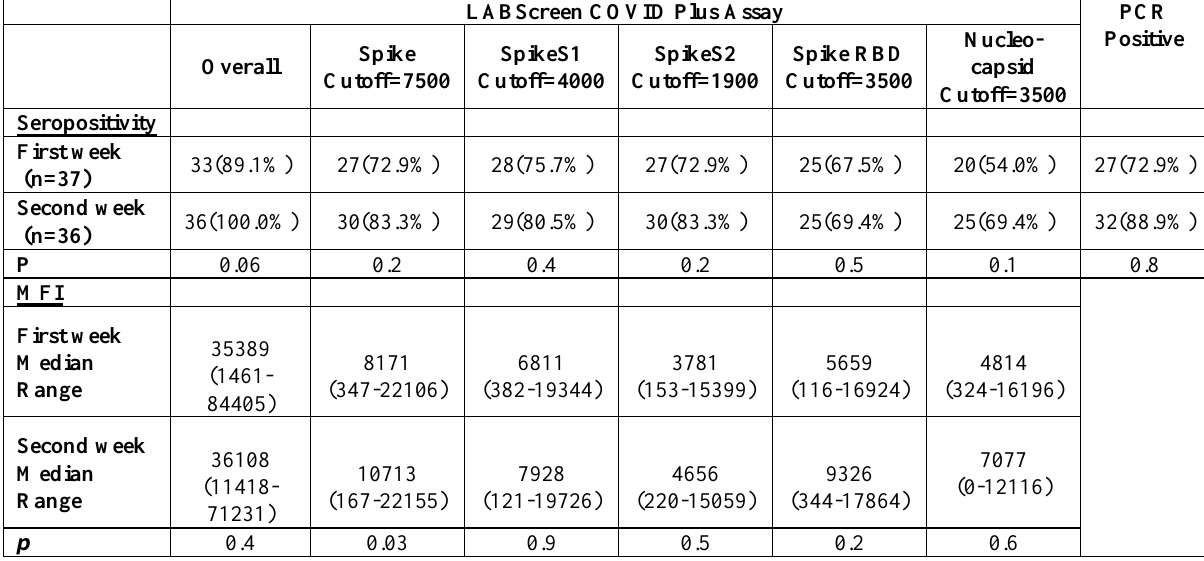
Table 2. Seropositivity and MFI of LABScreen COVID Plus assay in relation to time elapsed since symptoms onset.